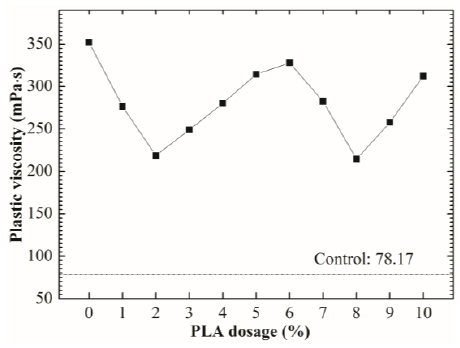
Figure 5. The plastic viscosity of the control and SDTSMs with different PLA dosages. Table 5. The weight percent of powders between different pore diameters sieves of PLA, slag and fly ash. Pore Diameter (μm) PLA